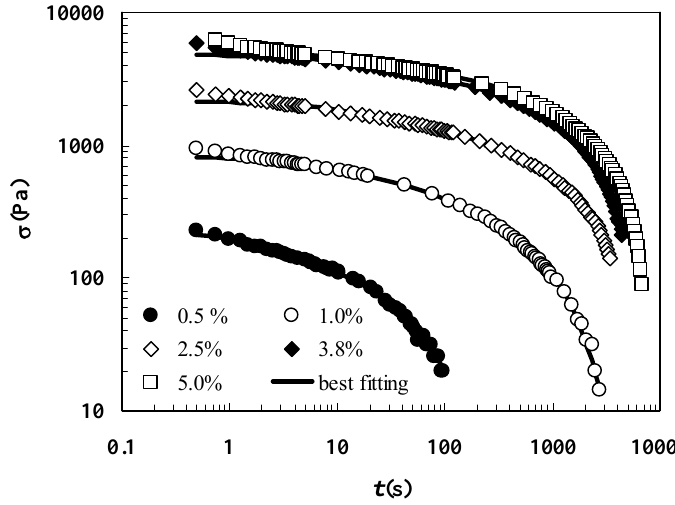
Figure 1. Comparison between the relaxation data (symbols) and model (Equation (1)) best fitting (solid line). σ and t represent the normal stress and time, respectively (constant = 10%; t = 0.5 s). Different polymer concentrations are considered (0.5%, deformation ε 0 1 1.0%, 2.5%, 3.8%,